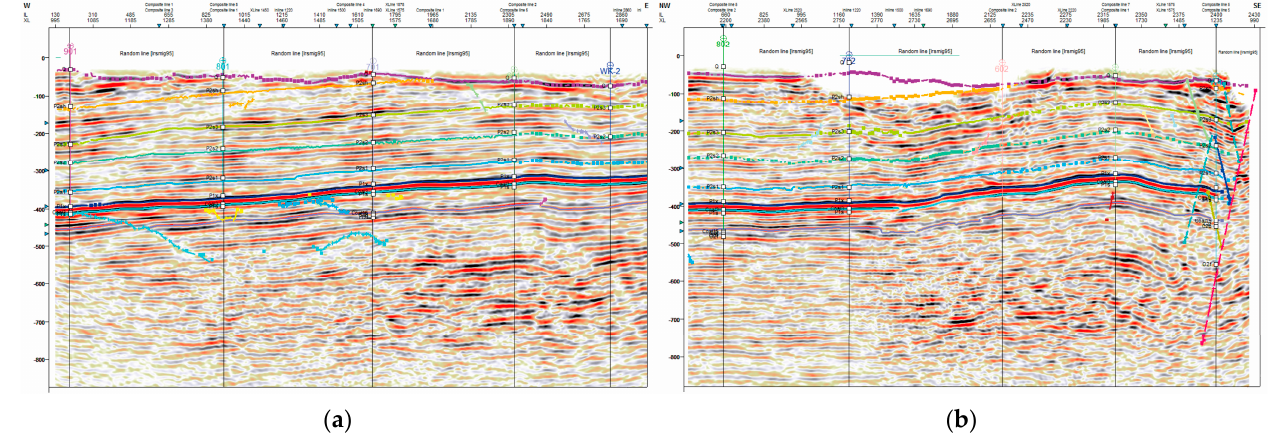
Figure 6. Well tie seismic profiles: ( a ) 1 − 1 well tie seismic profile; ( b ) 1 − 2 well tie seismic